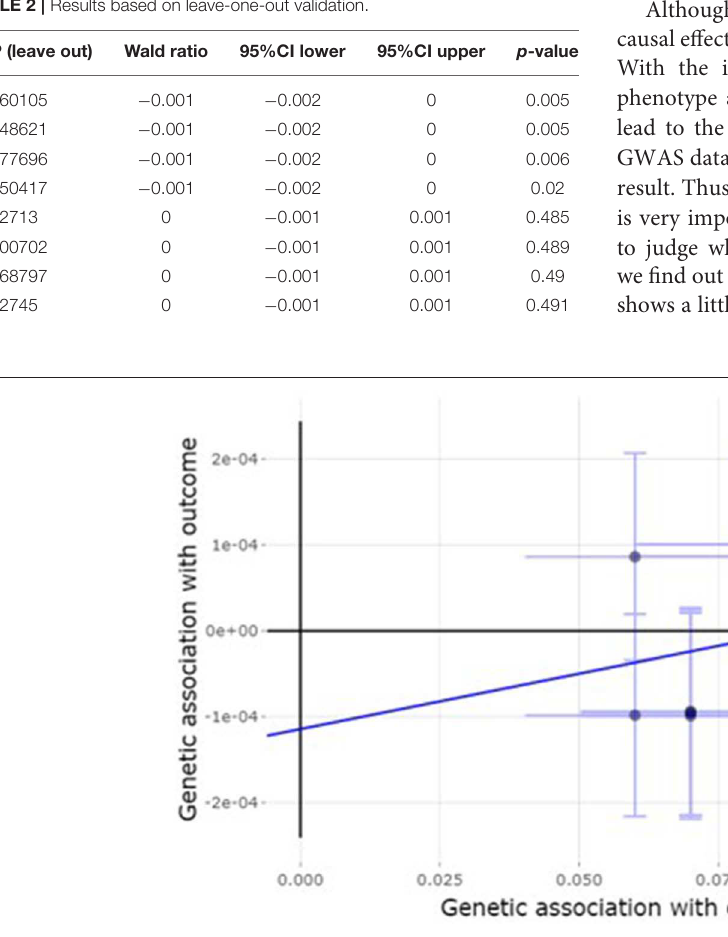
Frontiers in Bioengineering and Biotechnology |